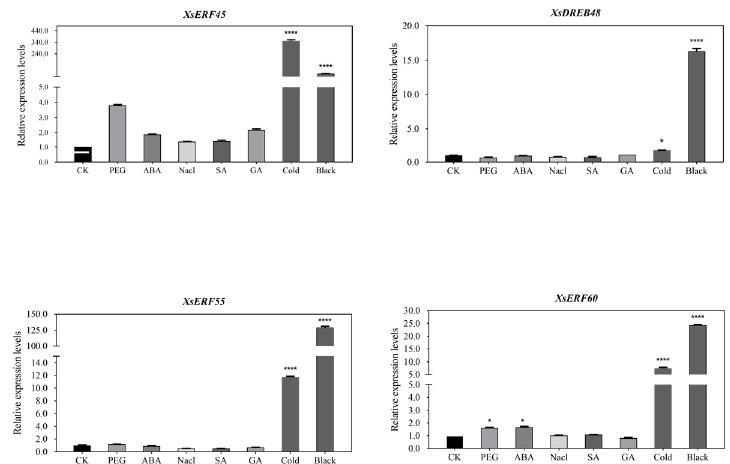
Figure 7. Real-time PCR analysis of 8 XsAP2/ERF transcription factors treated for 24 h under PEG, salt, cold, ABA, SA, and GA conditions and 48 h under dark conditions. The X -axis is a different treatment. The Y -axis represents the relative expression levels of transcription factors. The data represent the mean ± SE of three dependent replicates. A p -value less than 0.05 (*), or 0.0001 (****) indicates statistical significance.